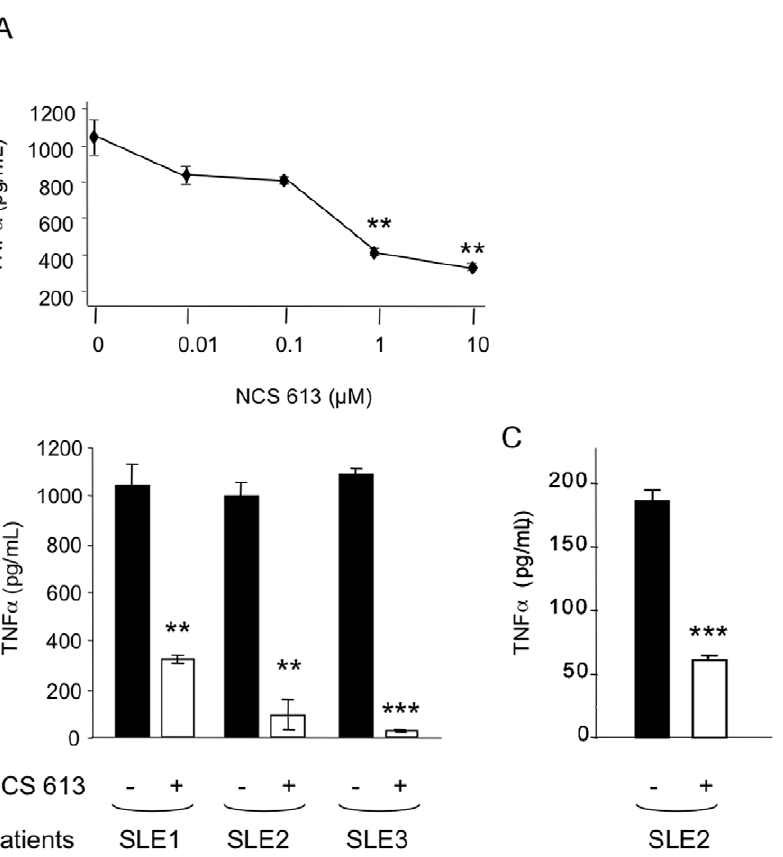
Figure 7. Effect of NCS 613 on LPS-induced and basal TNF a secretion by PBLs from SLE patients. PBLs from three patients with SLE (SLE1, SLE2 and SLE3) were purified and cultured as described in Materials and Methods. PBLs from SLE1 patient were incubated for 45 min with increasing doses of NCS 613 and stimulated with 5 m g/mL of LPS ( A ). PBLs were incubated for 45 min with ( % ) or without ( & ) 10 m M of NCS 613 and stimulated ( B ; SLE1, SLE2 and SLE3) or not ( C ; SLE2) with 5 m g/mL of LPS. TNF a secretion was determined by ELISA. The results are expressed as the